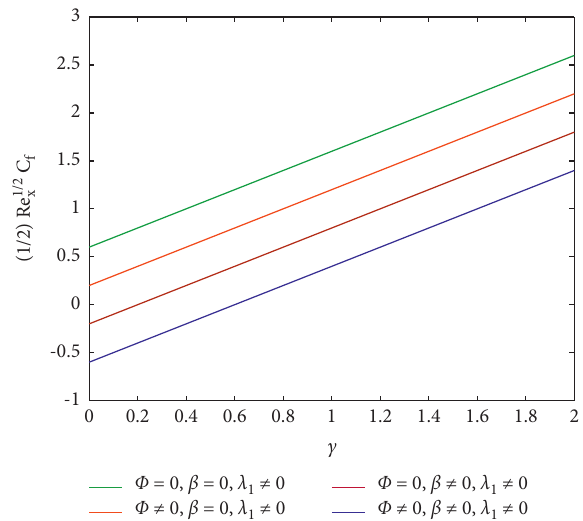
Figure 6: Different cases comparison of friction drag in the flow of MgZn Zr − C H and C H . 8 18 8 18 6